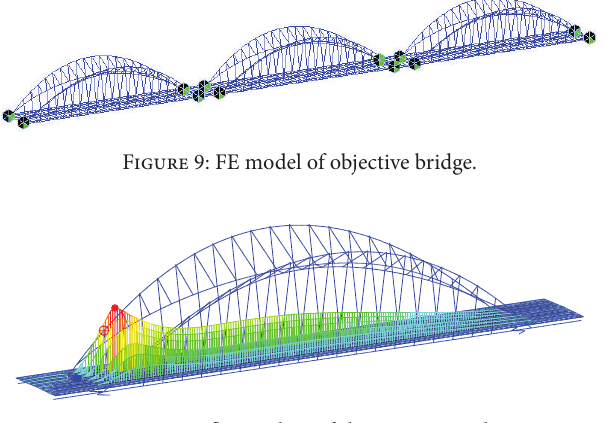
Figure 10: Influence line of shortest